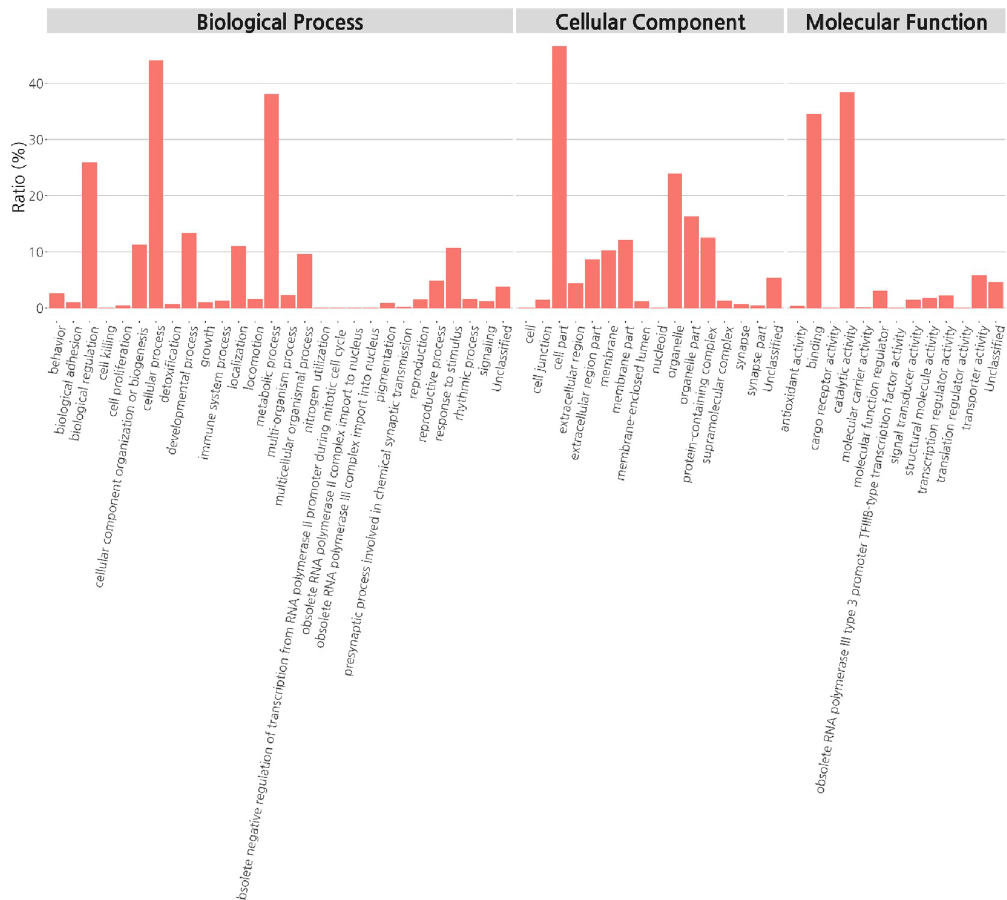
Fig 6. Gene Ontology (GO) functional classification analysis of differentially expressed genes (DEGs) between the control and ampicillin-treated groups. Based on sequence homology, 1,236 DEGs were categorized into three main categories, biological process, cellular component, and molecular function, with 28, 16, and 13 functional groups, respectively.